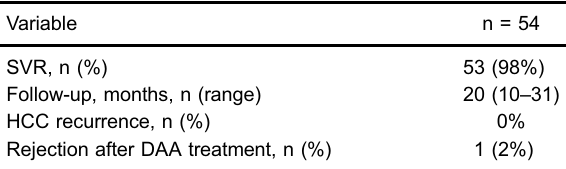
Table 4. Antiviral treatment